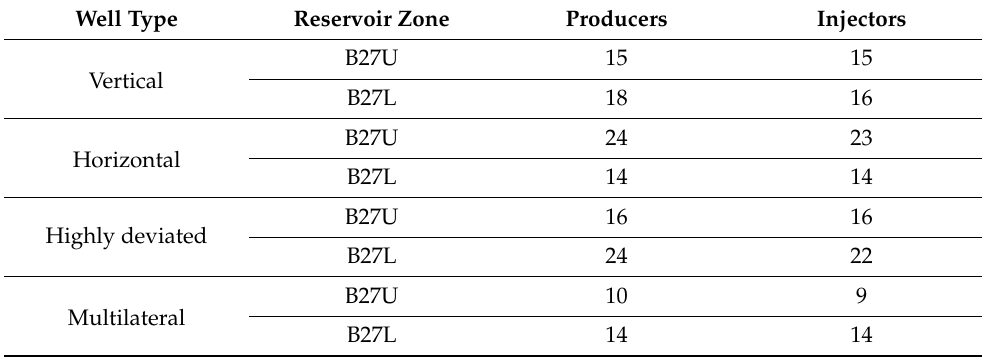
Table 7. Number of wells planned in each reservoir